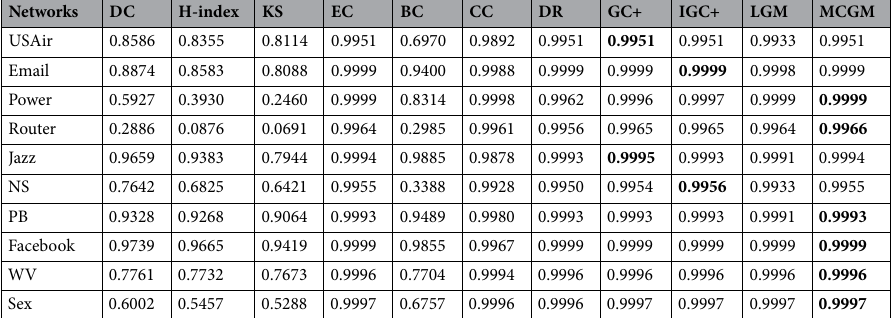
Table 7. The monotonicity of different algorithms. The parameters in the related algorithms (i.e., LGM and MCGM) are adjusted to their optimal values subject to the largest τ . For each network, the best algorithm is emphasized by bold.